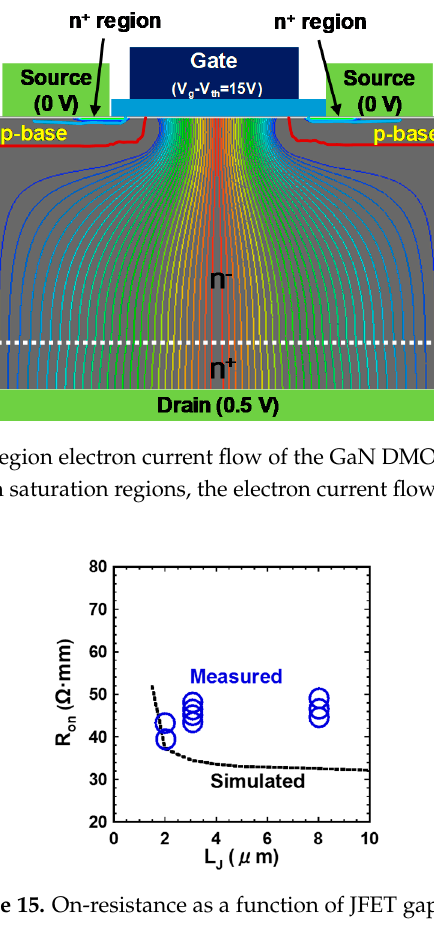
Figure 13. I ds - V ds characteristics of the DMOSFET. On-resistance of 46.4 Ω ·mm was measured at V gs = 15 V and V ds = 0.5 V.